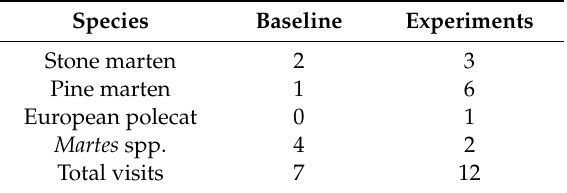
Table 3. Number of identified mustelid species dependent on the experimental